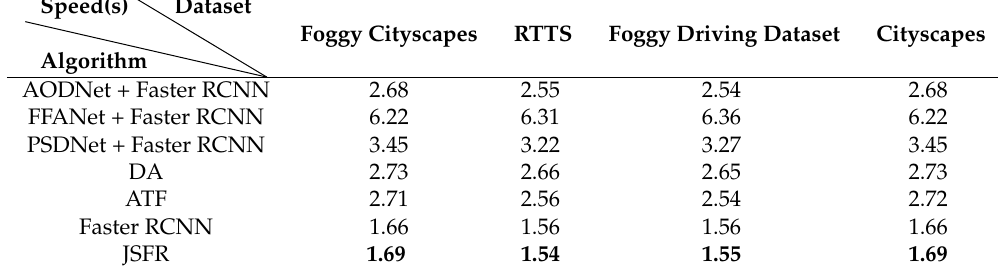
Table 5. Testing speeds of JSFR , combination methods including AODNet+Faster RCNN , FFANet + Faster RCNN , and PSDNet + Faster RCNN , domain adaptive methods including DA and ATF , and Faster RCNN on the four datasets with GPU